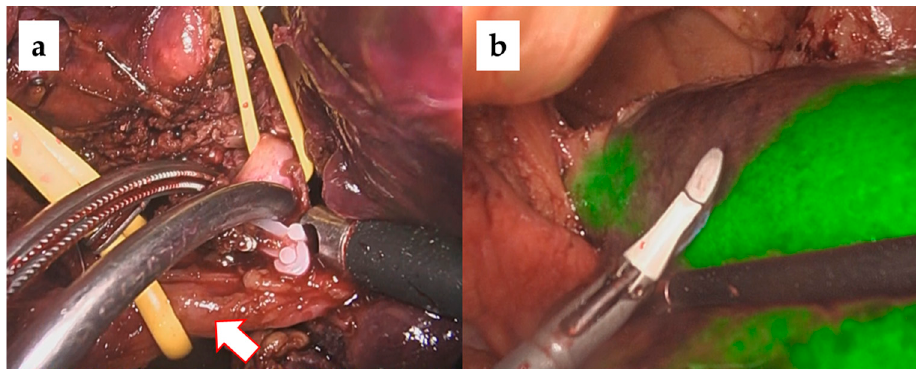
Figure 4. Laparoscopic subsegmentectomy (S3) with ICG negative staining ( a ) Securing and blocking the one of the branches of G3 (arrow: main trunk of G3). ( b ) ICG demarcation of subsegmentectomy of S3 (cone unit resection).